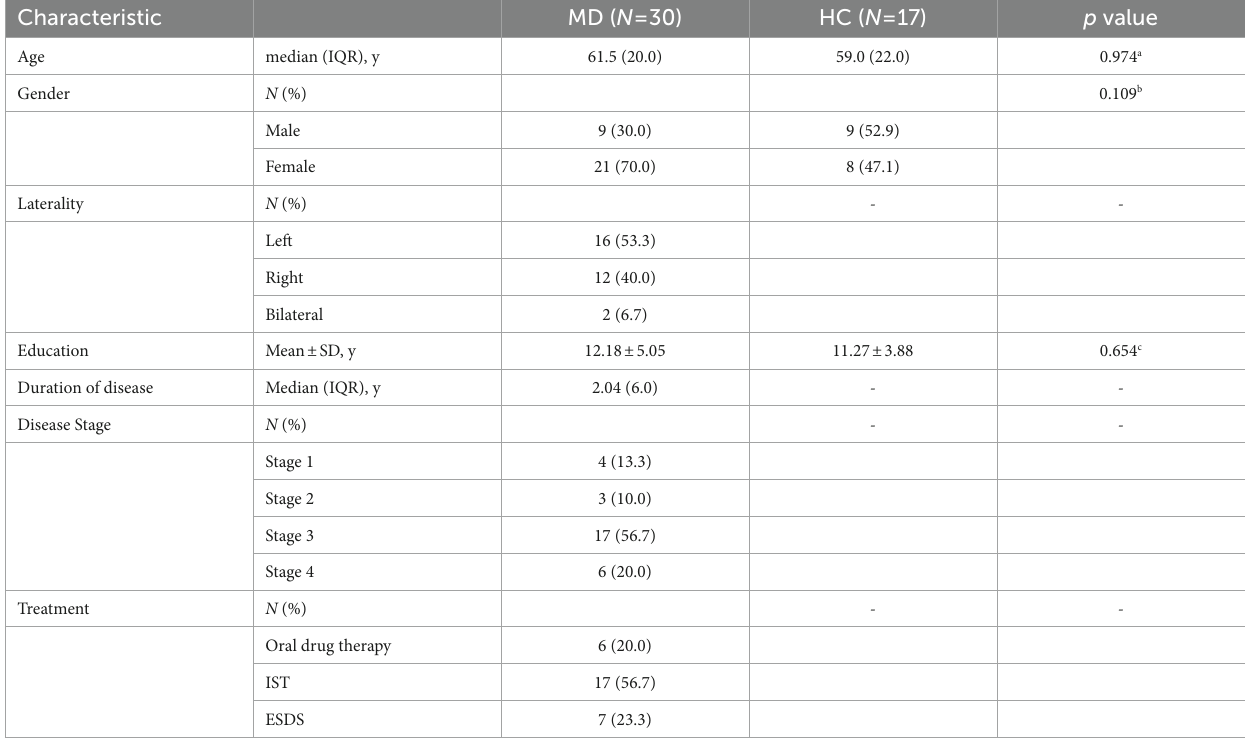
TABLE 1 Demographical and clinical properties of the participants.